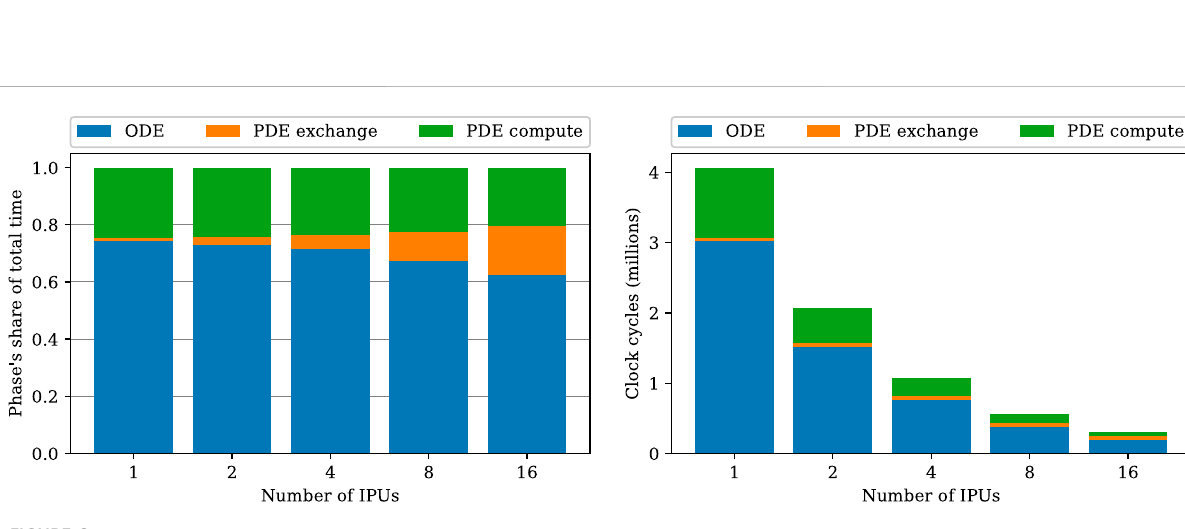
FIGURE 6 Breakdown ofthe strong-scaling experiments using the heart04 mesh. Blue denotes thetotal ODE step time composed of onlycompute, green is the compute phase of the PDE step, and orange denotes the cycles used for PDE